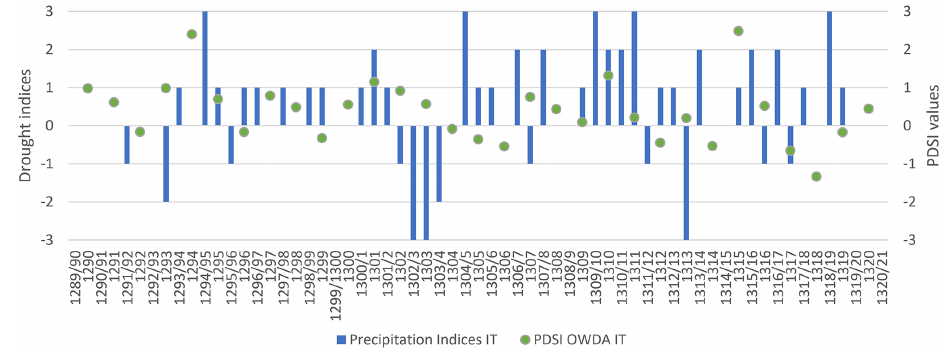
Figure 2. Reconstructed semi-annual drought indices and OWDA PDSI data for JJA from tree rings (Cook et al., 2015) for IT, 1290–1320.